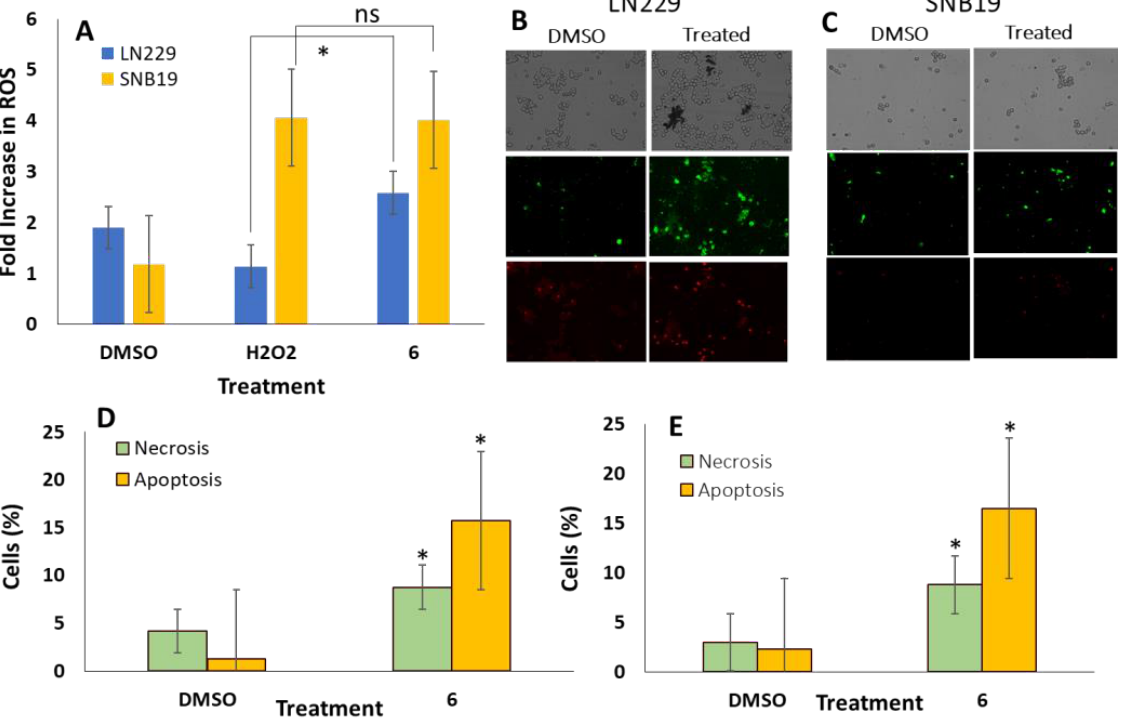
Figure 4. Validation of compound 6 -induced ROS changes in GBM cells. ( A ) Effect of compound 6 in intracellular ROS production in LN229 and SNB19 cells. Cells were treated with the IC 50 concentration for 5 h and intracellular ROS was measured from the fluorescence intensity of H 2 DCFDA. DMSO and H 2 O 2 were used as negative and positive controls, respectively. ( B , C ) Microscopic im- ages of the cells stained with Annexin V-FITC and PI in ( B ) LN229 and ( C ) SNB19 cells. Image pan- els: DMSO- and compound 6 -treated cells. ( D , E ) Percentage of apoptotic and necrotic cells in DMSO- and compound 6 -treated conditions for ( D ) LN229 and ( E ) SNB19 cells. Datapoints and error bars represent mean ± S.E.M (n = 6). * p < 0.05 relative to the respective control. ns, statistically non-significant.